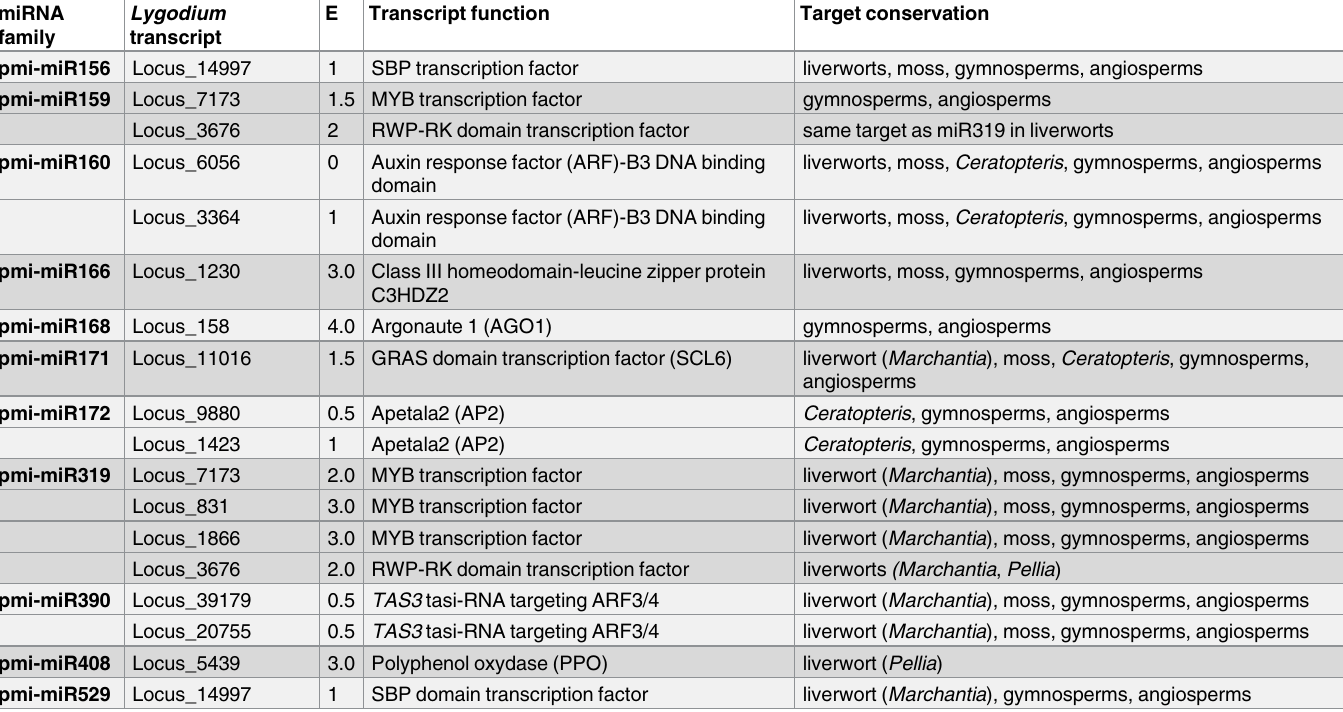
Table 2. Putative conserved fern targets of P . minima